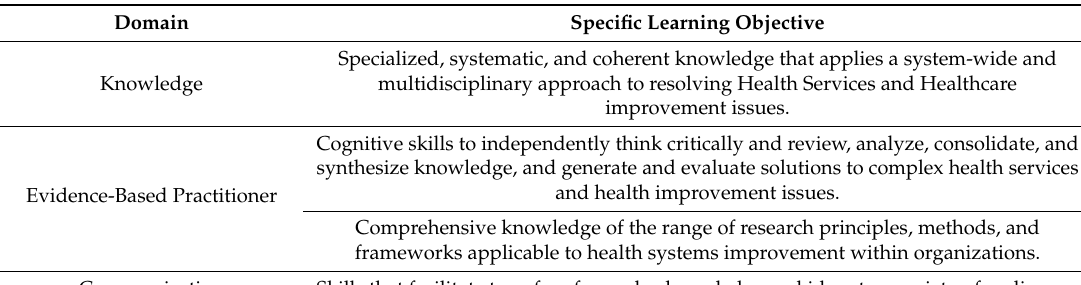
Table 1. Overall Learning Objectives for the